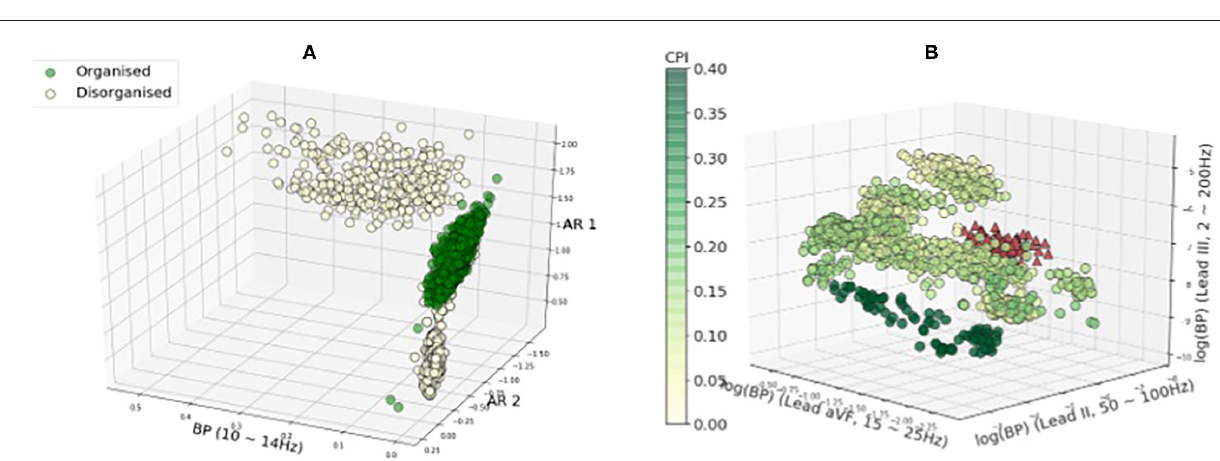
FIGURE 7 | Feature distribution regarding the fibrillatory organisational level. The three best features selected by mutual information were plotted. The colour of the features are corresponding to the CPI values except features of subject clinical-10 in red. In General, the features with the high and low CPI are separated. However, features of subject clinical-10 with high CPI (in red triangles) tend to be overlapped with features from the low-CPI group. (A) Rat VF features. (B) Clinical AF